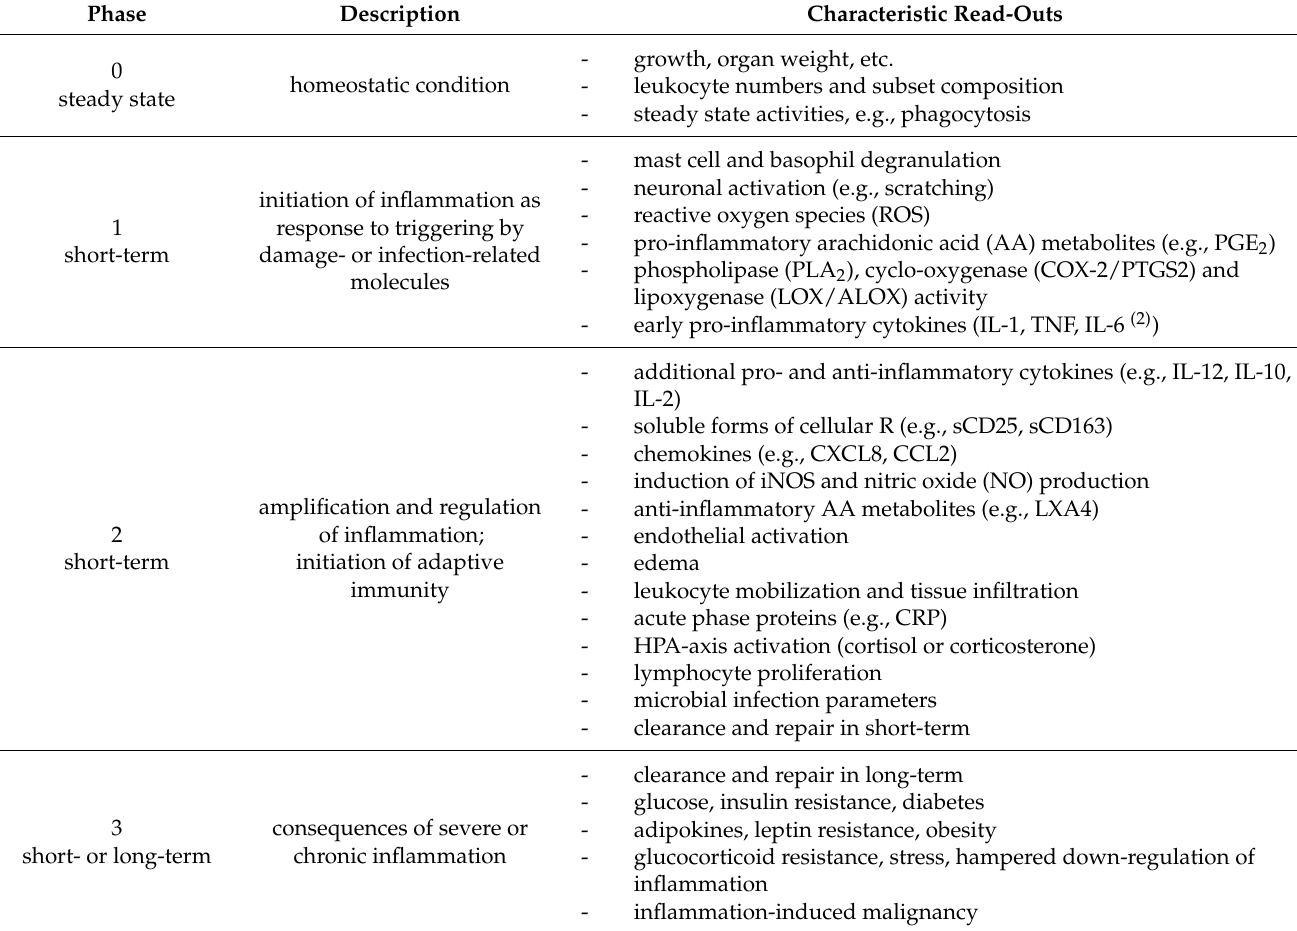
Table 1. Phases of the inflammatory response with characteristic features (1)